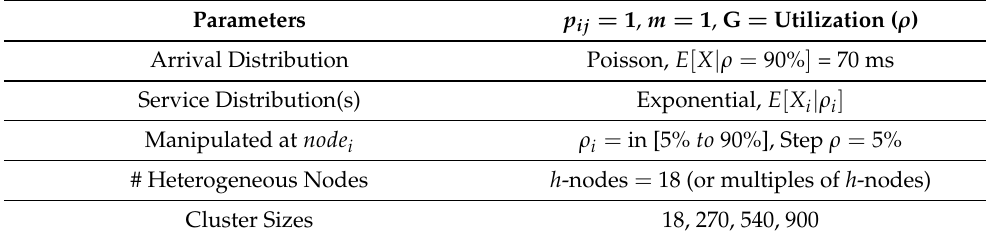
Table 1. HFJQNs of different nodes utilizations.